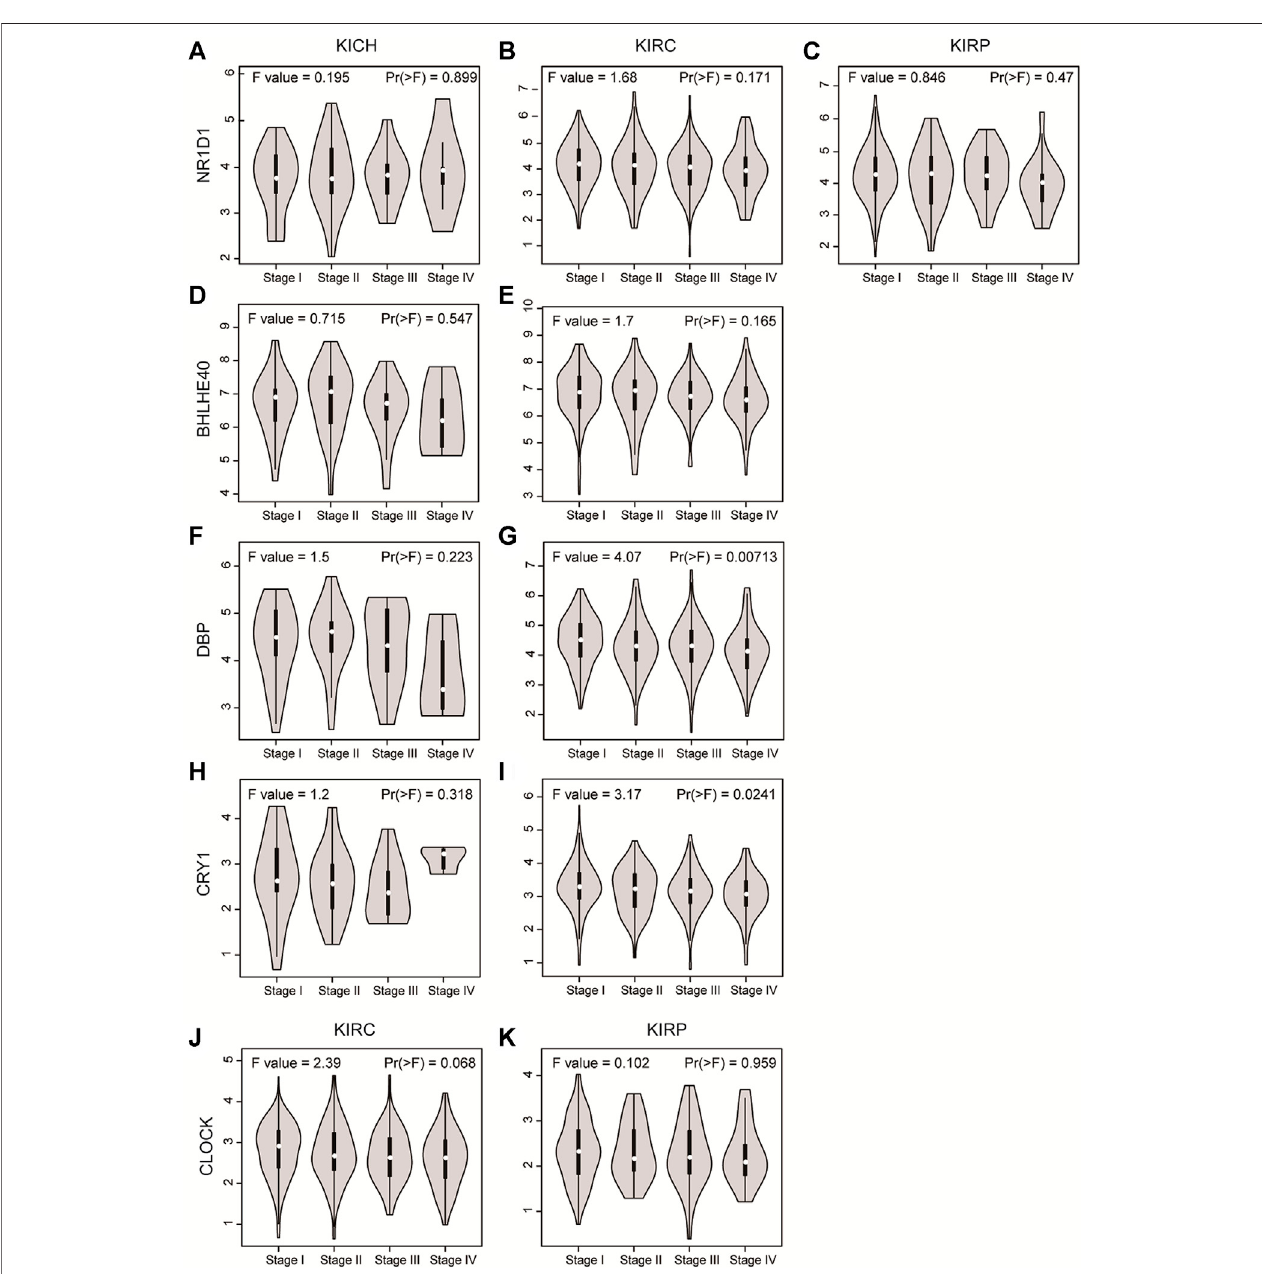
FIGURE3 | Theviolinplot showed the expression level of NR1D1, BHLHE40, DBP, CRY1 and CLOCK indifferentstages ofpan-RCC. (A – C) NRID1expression in the stage of pan-RCC. (D,E) BHLHE40 expression in the stage of KICH and KIRC. (F,G) DBP expression in the stage of KICH and KIRC. (H,I) CRY1 expression in the stage of KICH and KIRC. (J,K) CLOCK expression in the stage of KICH and KIRC. The parameters were listed in the